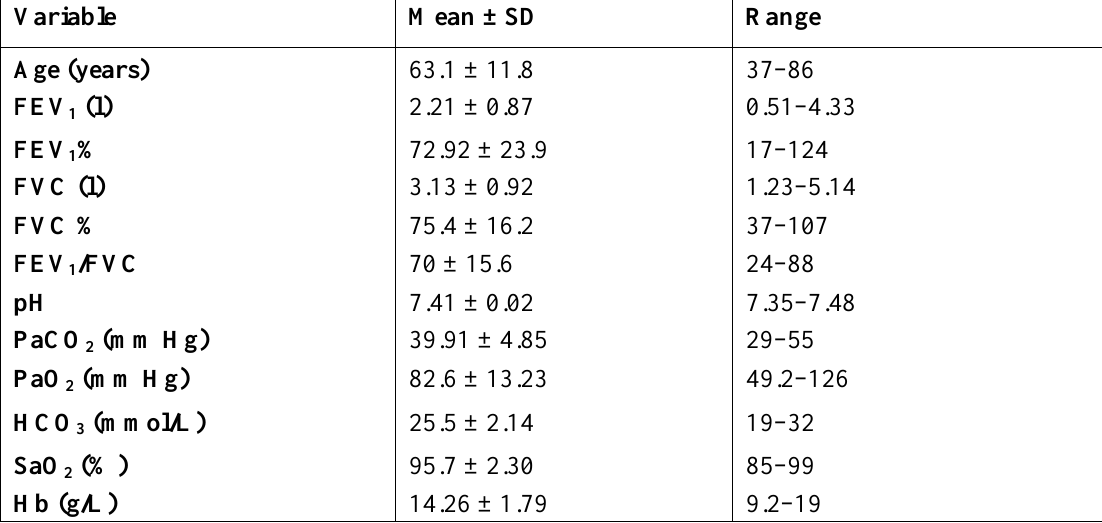
Table 1 . Demographic data and pulmonary function testing and arterial blood gas values (mean ± SD) of 91 patients included in the study.